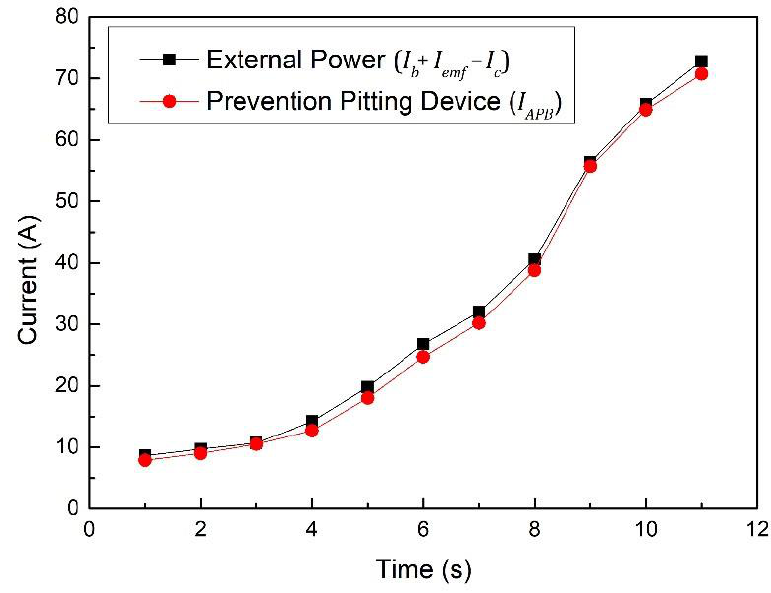
Figure 9. Current variation using electrical pitting prevention device to offset any external current supplied to the rotating shaft.